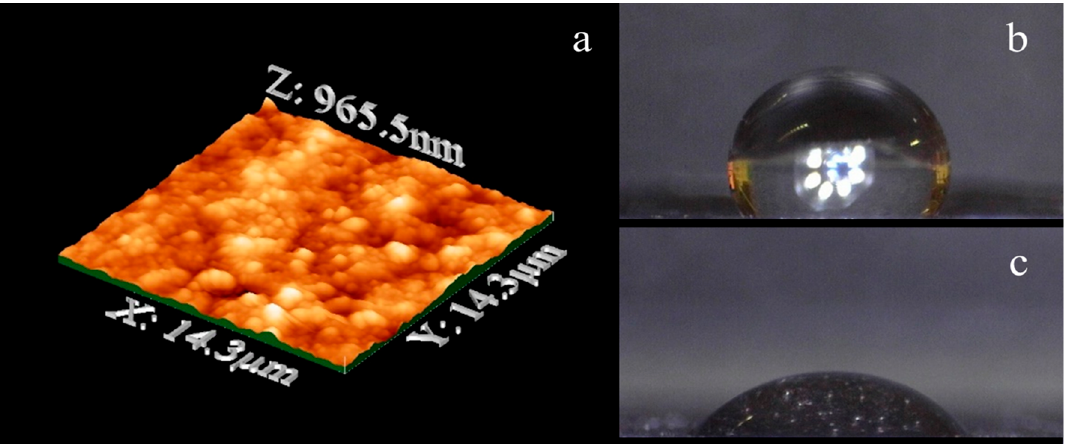
Figure 6. ( a ) AFM topology image of a WO 3 /BP membrane. The average rms roughness is 0.268 μ m; ( b ) Average contact-angle value of a BP membrane; ( c ) Average contact-angle value of a WO 3 /BP membrane.